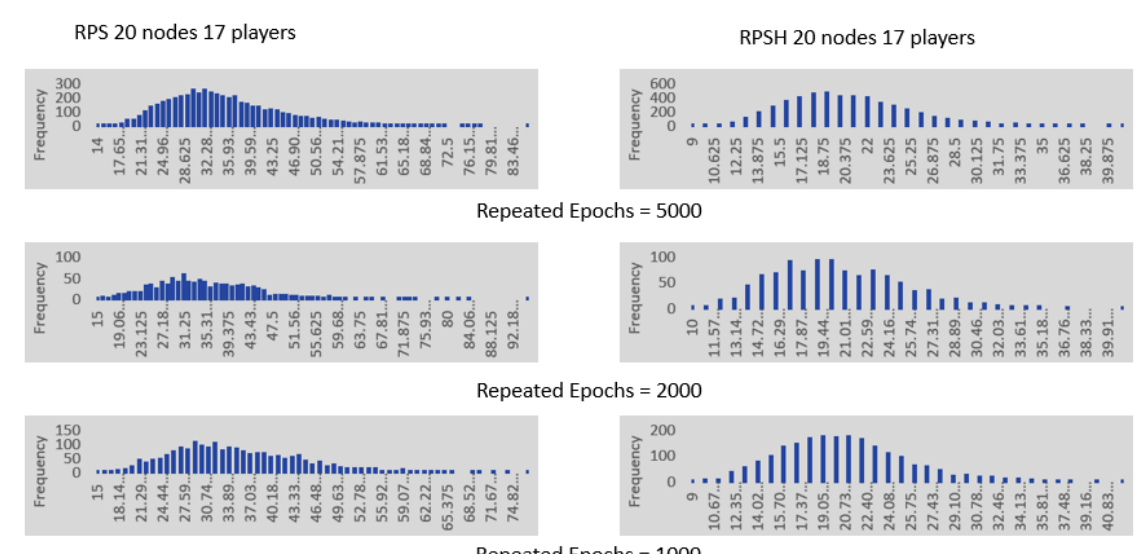
i.e., to move the test player from left-most node to the right-most node. The distribution of number